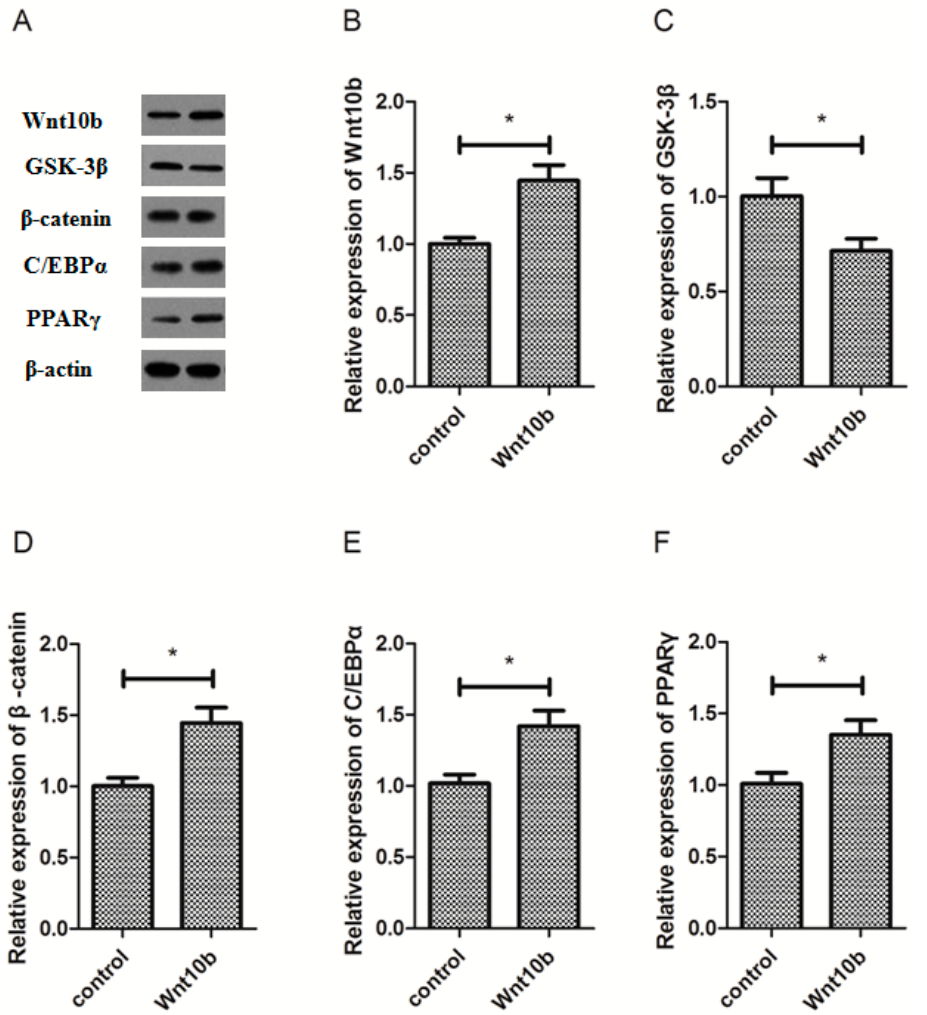
Figure 2. E ff ect of Wnt10b gene overexpression on the protein expression of Wnt10b, GSK-3 β , β -catenin, C / EBP α , and PPAR γ in the muscle of zebrafish. ( A ) The protein bands; ( B ) Wnt10b; ( C ) GSK-3 β ; ( D ) β -catenin; ( E ) C / EBP α ; ( F ) PPAR γ . Values are expressed as means ± s.e.m. ( n = 4). Statistically significant di ff erences are denoted by an asterisk (* p < 0.05).